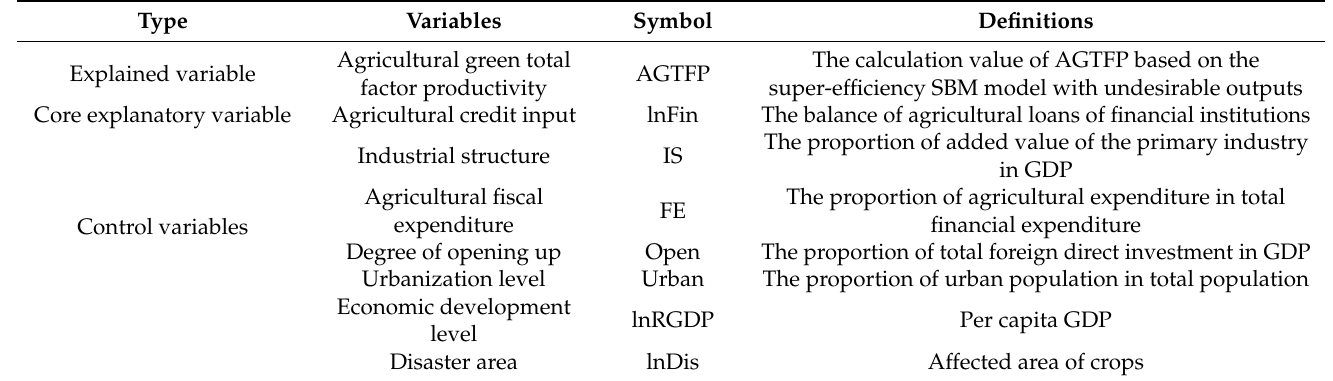
Table 3. The definitions and symbols of all variables.